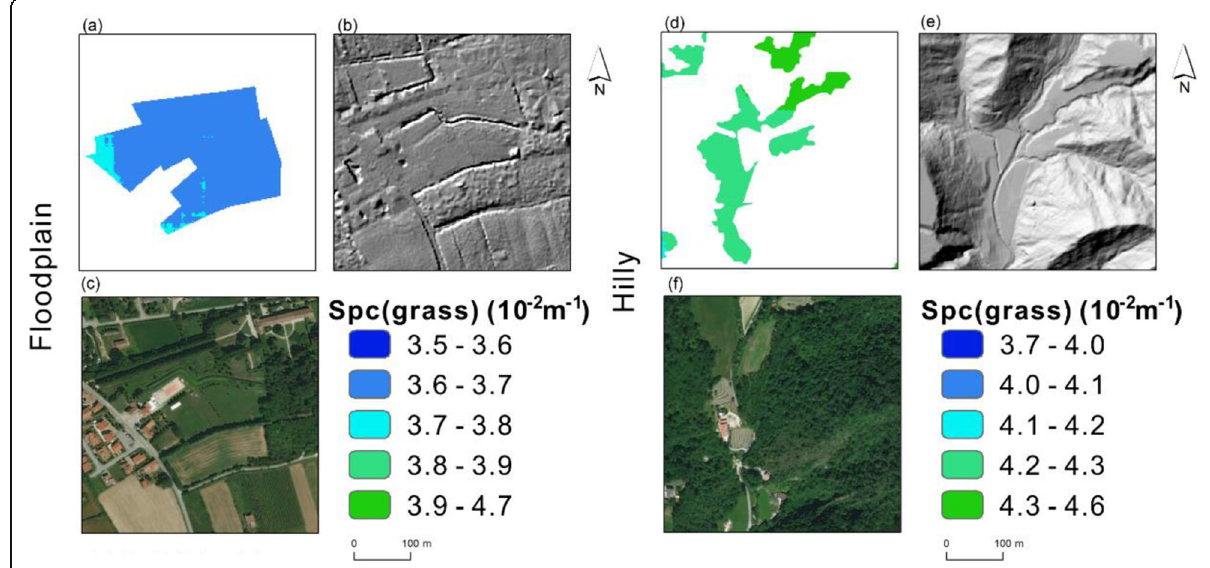
Fig. 15 Grass with Spc value in floodplain ( a ) and hilly ( d ), LiDAR-derived shaded relief map in floodplain ( b ) and hilly ( e ), and satellite image in floodplain ( c ) and hilly ( f ); panels d and f are the 3D view from Google map in these two study